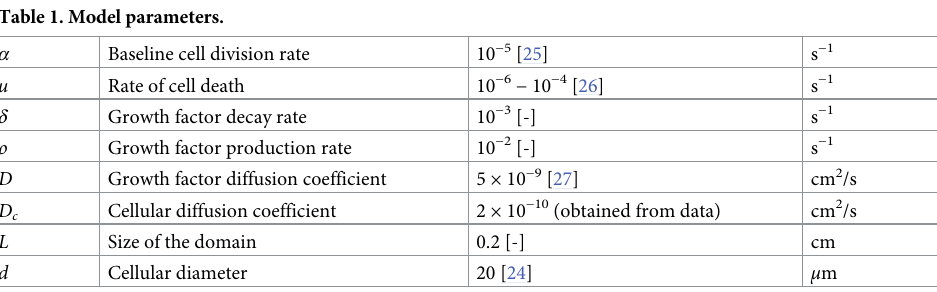
Table 1. Model parameters.